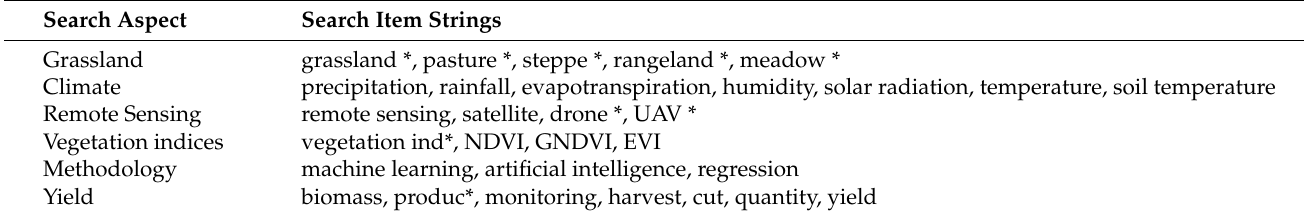
Table 1. Identified search item strings for systematic literature review.